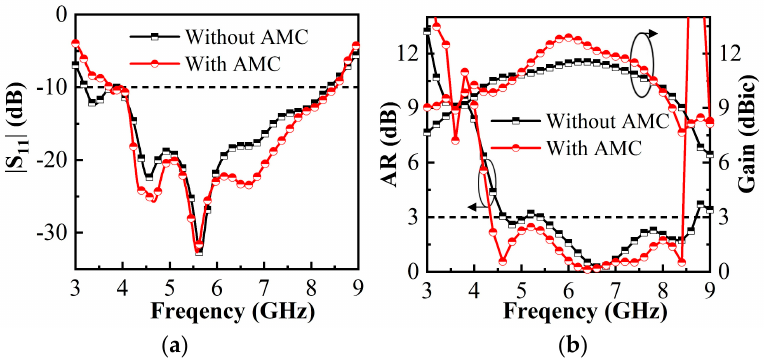
Figure 8. Simulated results of the crossed ‐ dipole with/without AMC. ( a ) |S 11 |. ( b ) AR and gain. A prototype was fabricated and measured to verify the performance of the proposed antenna. The reflection coefficient of the antenna was measured using an E5071C network analyzer, and the AR, gain, and radiation patterns were measured using a Satimo System in an anechoic chamber. Figure 9 shows the simulation and measurement results of the reflection coefficient. The simulated and measured − 10 dB |S 11 | bandwidths are 72% (4.0–8.5 GHz) and 74% (4.0–8.7 GHz), respectively. The measurement result is in good agreement with the simulation result, although there are slight deviations. The simulated 3 dB AR bandwidth is 62.5% from 4.4 GHz to 8.4 GHz, and the measured AR bandwidth is 67.7% from 4.3 GHz to 8.7 GHz. In addition to the good consistency of the bandwidth, the measured and simulated results also have similar trends and approximate minimum AR points. Both the simulated and measured gains are greater than 7 dBic within the operating band. The peak gain is 12.9 dBic for the simulation and 12.1 dBic for the measurement, and the average gains are 11.22 dBic and 10.69 dBic, respectively. The measured gain and simulated gain also have similar trends, but there is an inevitable gain loss due to the fabrication error and deviation in the measurement system.